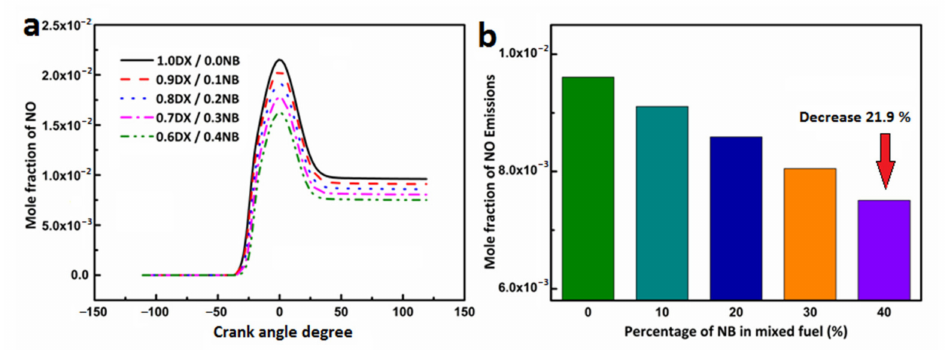
Figure 12. ( a ) Effect of DX and n-butanol blending ratio on NO emissions; ( b ) Effect of n-butanol percentage on final NO emissions.